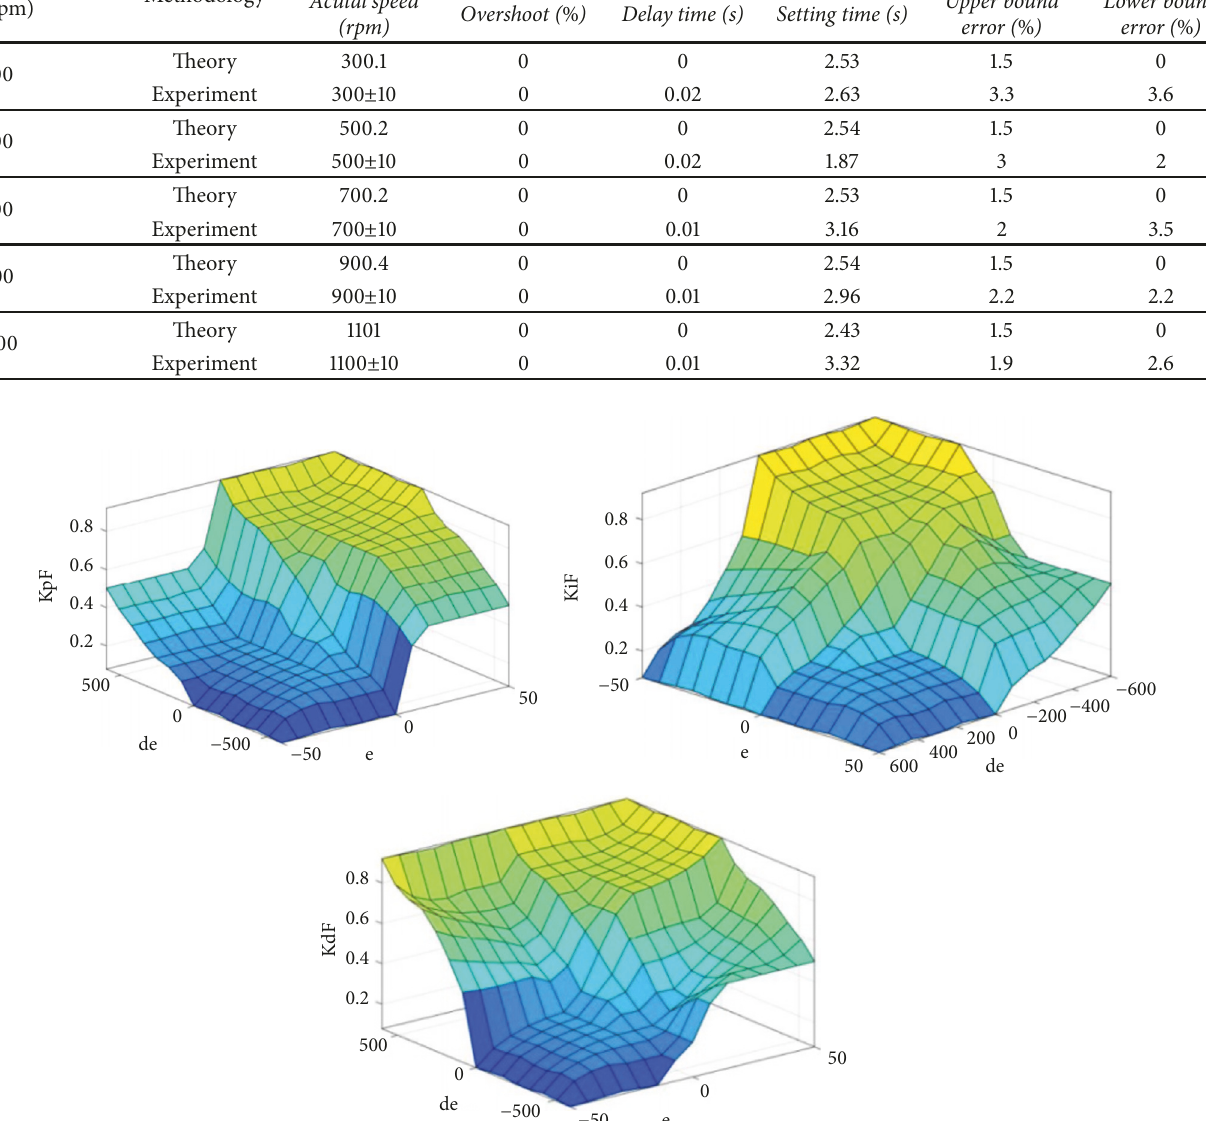
Figure 8: The ouput variables of the fuzzy self-tuning PID controller.